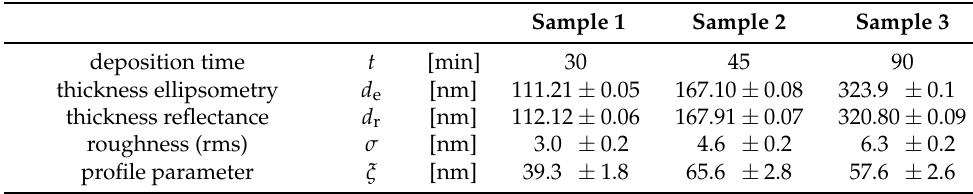
Table 2. The values of the structural